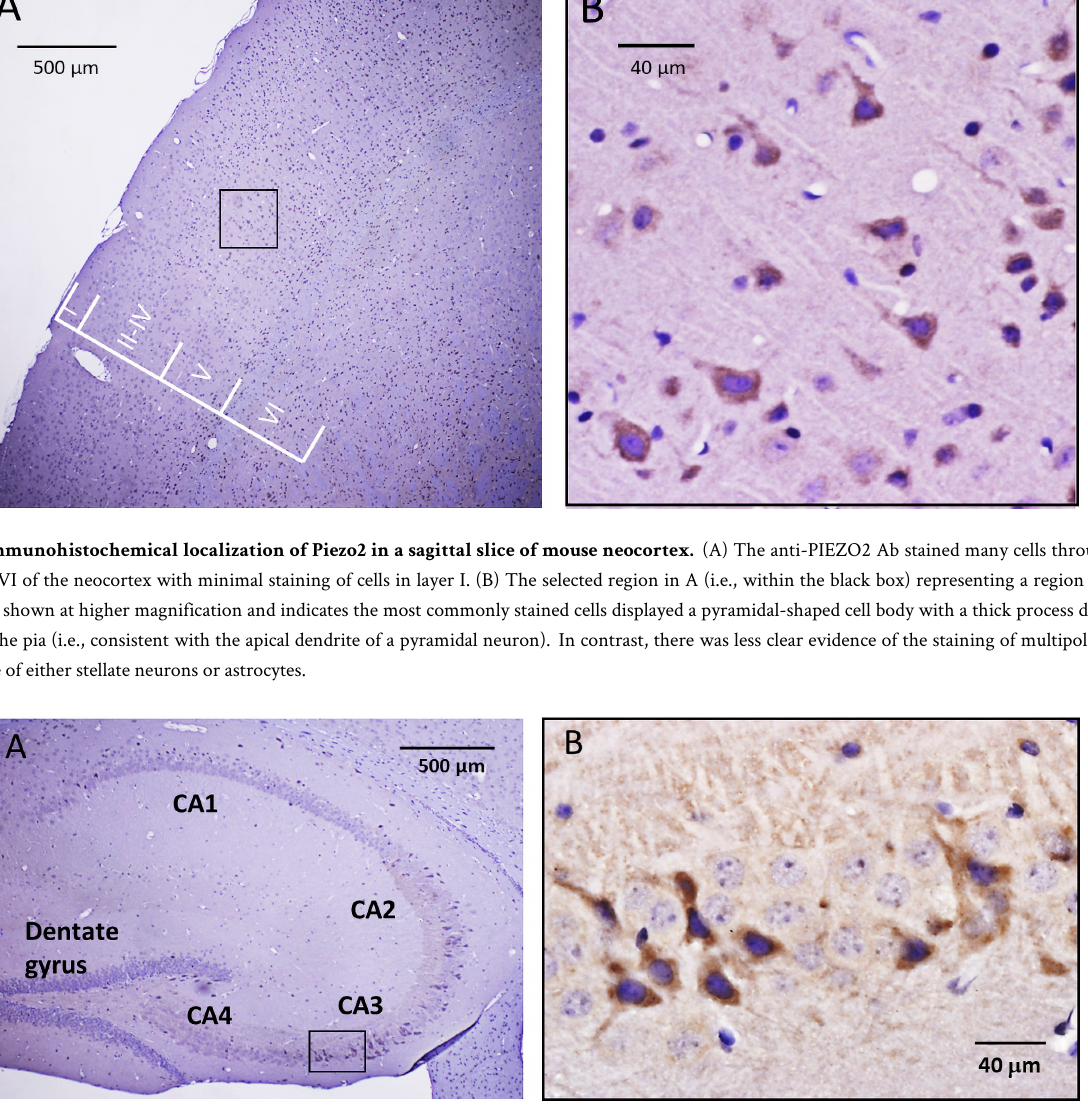
Fig. 3. Immunohistochemical localization of Piezo2 in mouse hippocampus. (A) Low magnification image of a hippocampal sagittal slice showing distinct divisions, including the dentate gyrus (DG) and CA4–CA1 regions. (B) The selected region in A (i.e., within the black box) that involves part of the CA3 region is shown at higher magnification and indicates at least 11 heavily stained cells, some of which displayed a distinct pyramidal-shaped cell body and a single prominent process. Within the same region, ~25 cells were stained blue by hematoxylin but showed no Ab staining. This all-or-none staining is at least consistent with the idea of a stochastic on-off switch controlling neuron type-specific Piezo2